Question: Describe this figure in one sentence.
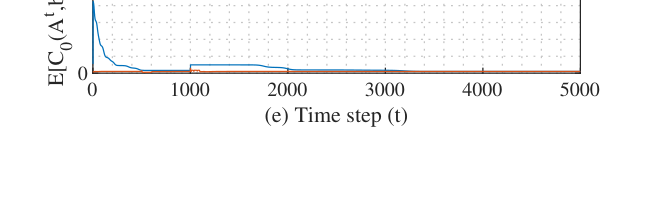
Answer: (a) The regret of both methods. (b) The Euclidean distance between two consecutive probability distributions produced by Algorithm 1, (c) the corresponding reservation const (E[C(At, Bt)]), and (d) the blocking cost (E[C0(At, Bt)]) .